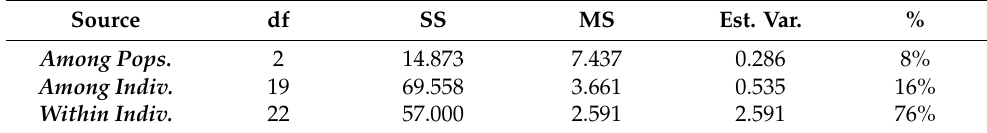
Table 6. Analysis of molecular variation (AMOVA) among and within three Calabrian hops populations. Table 7. Nei and Li (1979) [37] genetic distance (below diagonal) and Pair-wise estimates Fst (above Source df SS MS Est. Var. diagonal) based on SSR markers among Calabrian hops populations. Among Pops. Among Indiv. Within Indiv. Table 7. Nei and Li (1979) genetic distance (below diagonal) and Pair-wise estimates Fst (above diagonal) based on SSR markers among Calabrian hops populations.